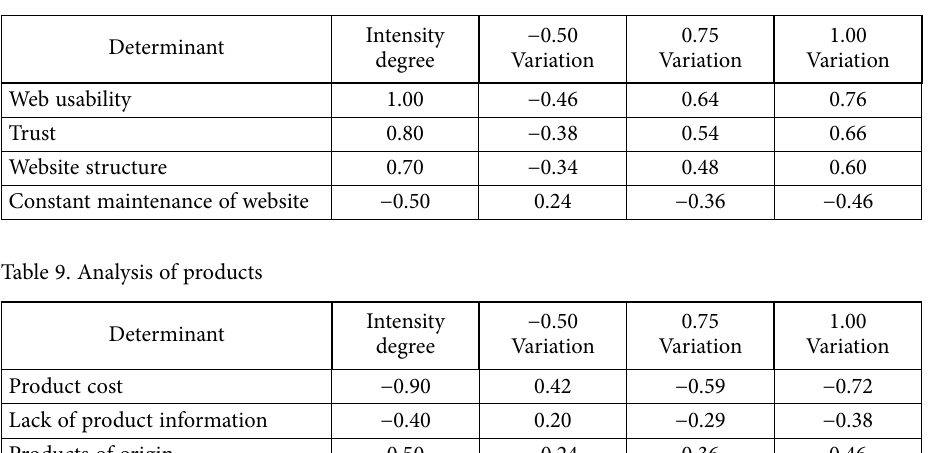
Table 8. Analysis of website and digital platform